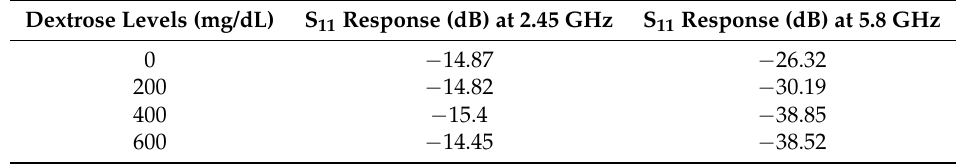
Table 4. Comparison of patch antennas operating at 2.45 GHz and 5.8 GHz tested with deionized water–dextrose solutions